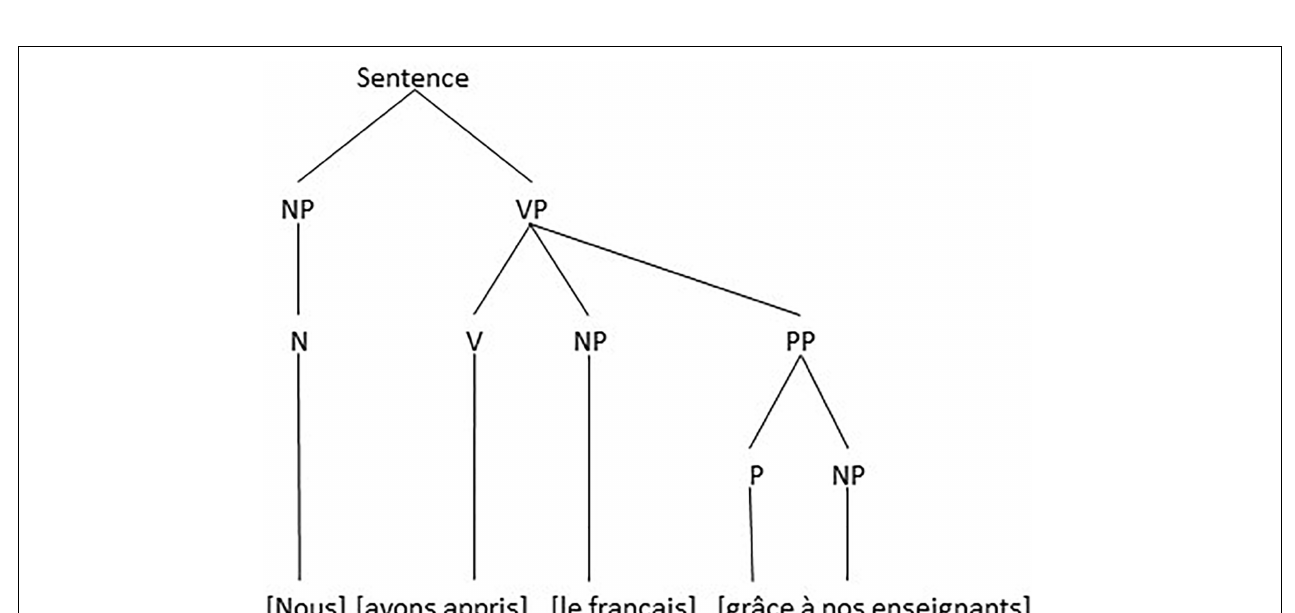
FIGURE 1 | Two possible morphosyntactic structures: (A) the verb has one complement, which can be moved to the initial position, and (B) the verb has two complements, each of which can be fronted.